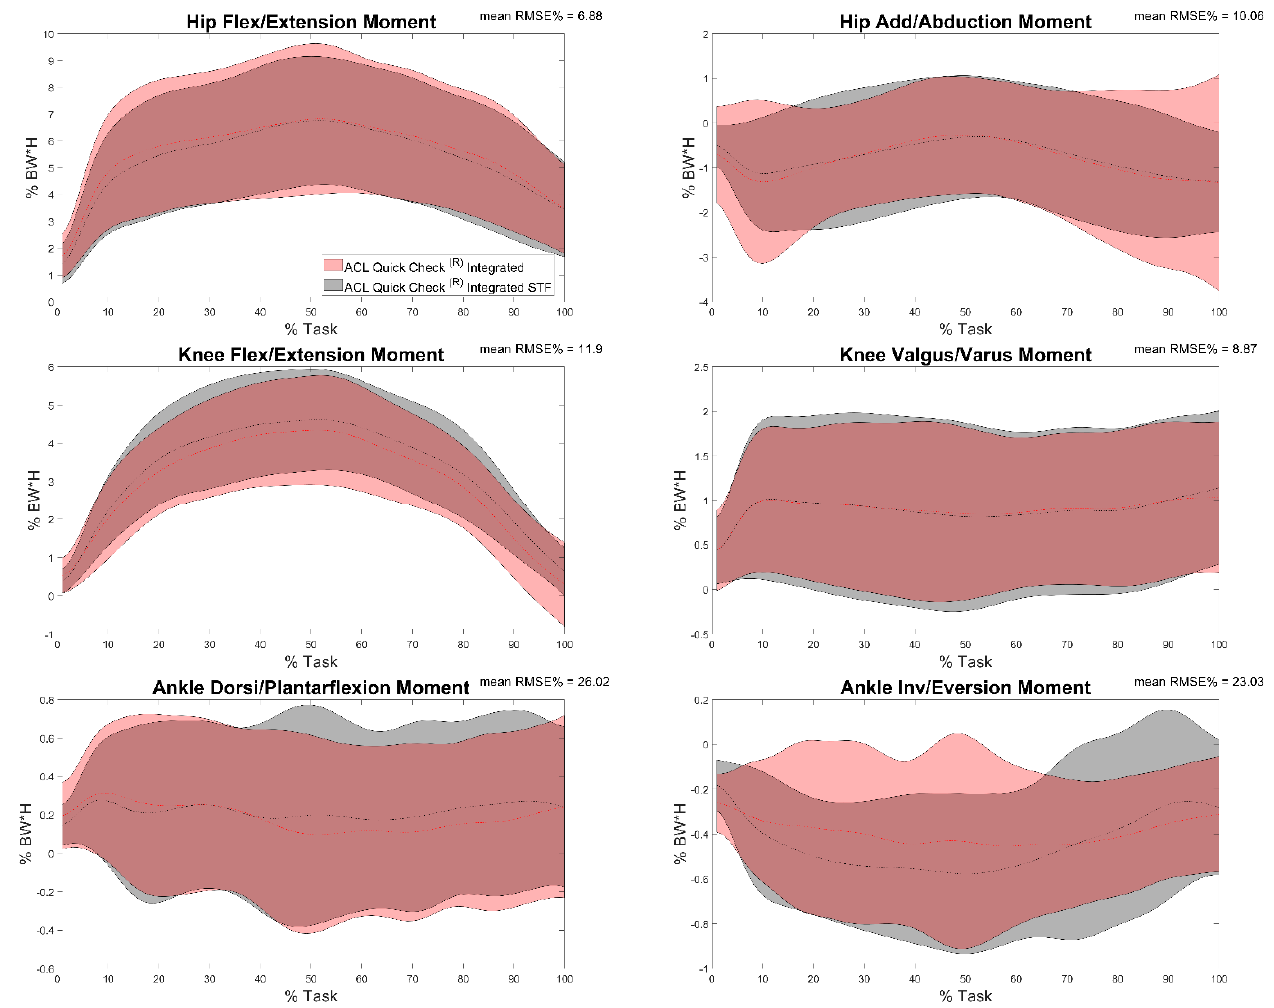
Figure 8. Hip, knee and ankle adduction/abduction and flexion/extension moments during the task calculated through ACL Quick Check ® integrated by considering the data acquired with the stereophotogrammetric system (gray) and through ACL Quick Check ® integrated by considering the data acquired with commercial video cameras (red) and mean of RMSE% of the comparison between the two. Averages plus and minus one standard deviation are reported as colored bands.